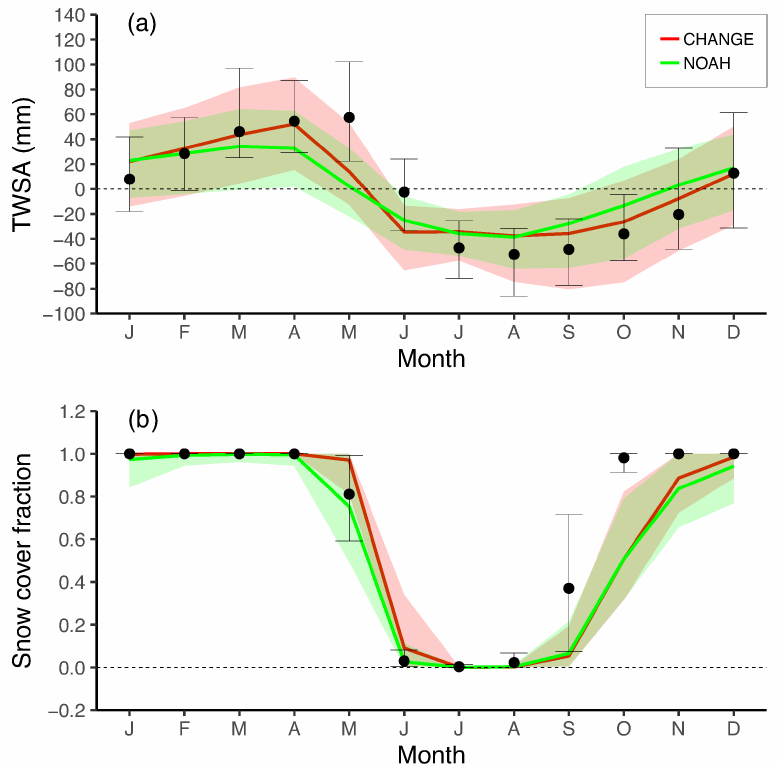
Figure 6. Comparison of estimated terrestrial water storage anomaly (TWSA) and snow cover fraction (SCF) using CHANGE and NOAH models. Black circles and error bars denote the GRACE-based observation datasets and their 95% confidence intervals (CIs), respectively. CHANGE is shown as a solid red line, with monthly climatology and 95% CIs presented in shades of red, whereas NOAH is shown as a solid green line, with monthly climatology and 95% CI presented in shades of green: ( a ) TWSA and ( b ) Snow cover